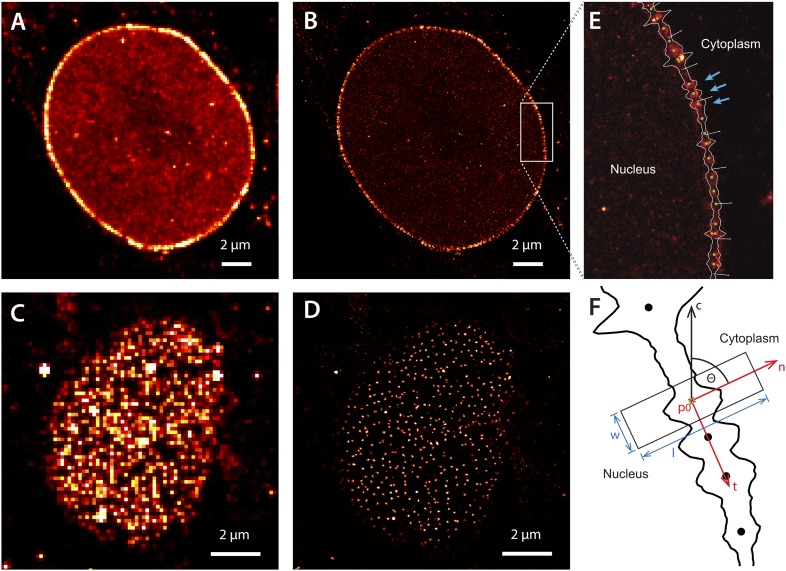
Super-resolution imaging of Alexa647-labeled impβ in digitonin-permeabilized HeLa cells.(A) Simulated widefield impβ localization at the equatorial plane of the nucleus and (B) corresponding dSTORM image. Mean localization precision is 12 nm. (C and D) Corresponding widefield and dSTORM images taken at the basal surface of the nucleus showing characteristic punctate NPC structures. (E) Zoom of the dSTORM image in (B), showing discrete NPC structures (examples, blue arrows). Putative NPC structures (green) markers are automatically identified using the linearized envelope localization histogram (shown in white, Supplementary methods). (F) Method for putative NPC structure isolation and alignment. Peaks in the envelope histogram (black line) are identified as potential locations for putative NPC structures (black circles). Localizations falling into a window (width, w, length, l) centred at these locations (p) are cropped out and rotated to a common frame, c, by the angle θ, maintaining the cytoplasm-nucleus vector, n.